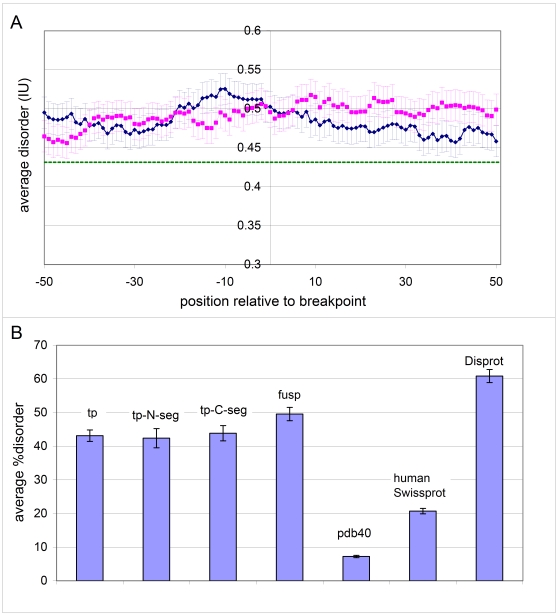
Structural disorder in translocation proteins and other proteins.
(A) Structural disorder in translocation proteins was predicted separately for the protein providing the N-terminal (blue) and C-terminal (magenta) segment of the fusion protein generated by the translocation event. Error bars represent SDs. (B) Mean disorder values for translocating proteins (tp), N-, and C-terminal segments (tp-N-seg, tp-C-seg) and fusion products (fusp) were predicted with IUPred. For reference, the mean disorder of proteins in the PDB database (pdb40, 40% non-redundant in sequence similarity), all human proteins in Swissprot (SwissProt) and experimentally determined disordered proteins/segments in DisProt (DisProt), are also shown. Error bars represent SDs.